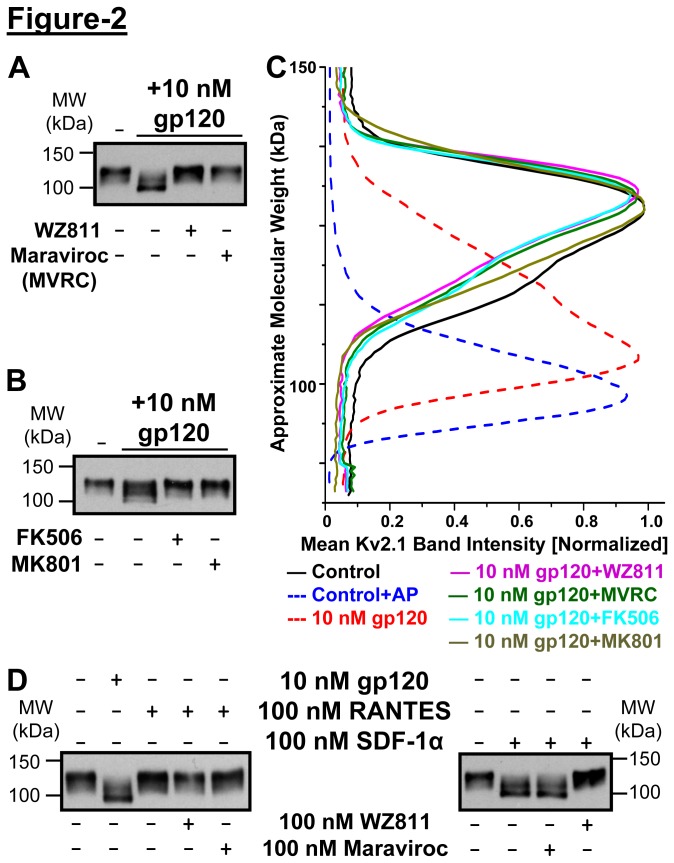
HIV-1 gp120-induced dephosphorylation of Kv2.1 is dependent upon activation of CCR5 and CXCR4, as well as on NMDA receptor-mediated activation of protein phosphatase 2B or calcineurin.
A, gp120-induced (10 nM, 30 min) Kv2.1 dephosphorylation was attenuated upon pre/co-application of inhibitors of CXCR4 (WZ811, 100 nM) or CCR5 (Maraviroc or MVRC, 100 nM) to cultured rat hippocampal neurons. B, gp120-induced Kv2.1 dephosphorylation could also be attenuated upon pre/co-application of cultured rat hippocampal neurons with the calcineurin inhibitor FK506 (10 µM), or the NMDAR antagonist MK801 (1 µM). C, Densitometric quantification of the extent of Kv2.1 phosphorylation state upon different drug treatments as shown in panels A & B. Data are presented as mean (n = 3 for each group). Dotted lines denote the same data traces from Figure 1D plotted for comparison. D, Direct activation of CXCR4, but not CCR5 by their respective endogenous chemokine agonists (SDF-1α and RANTES) led to dephosphorylation of Kv2.1 in cultured rat hippocampal neurons, which was attenuated by the CXCR4 inhibitor WZ811. Numbers on the left in blot panels denote the approximate molecular weight.